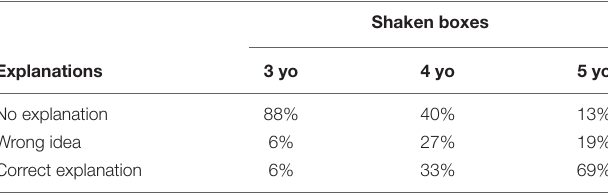
TABLE 4 | Percentage of children who gave the following explanations in response to the question "How did you know where the ball was?" in Experiment 4 ( N =